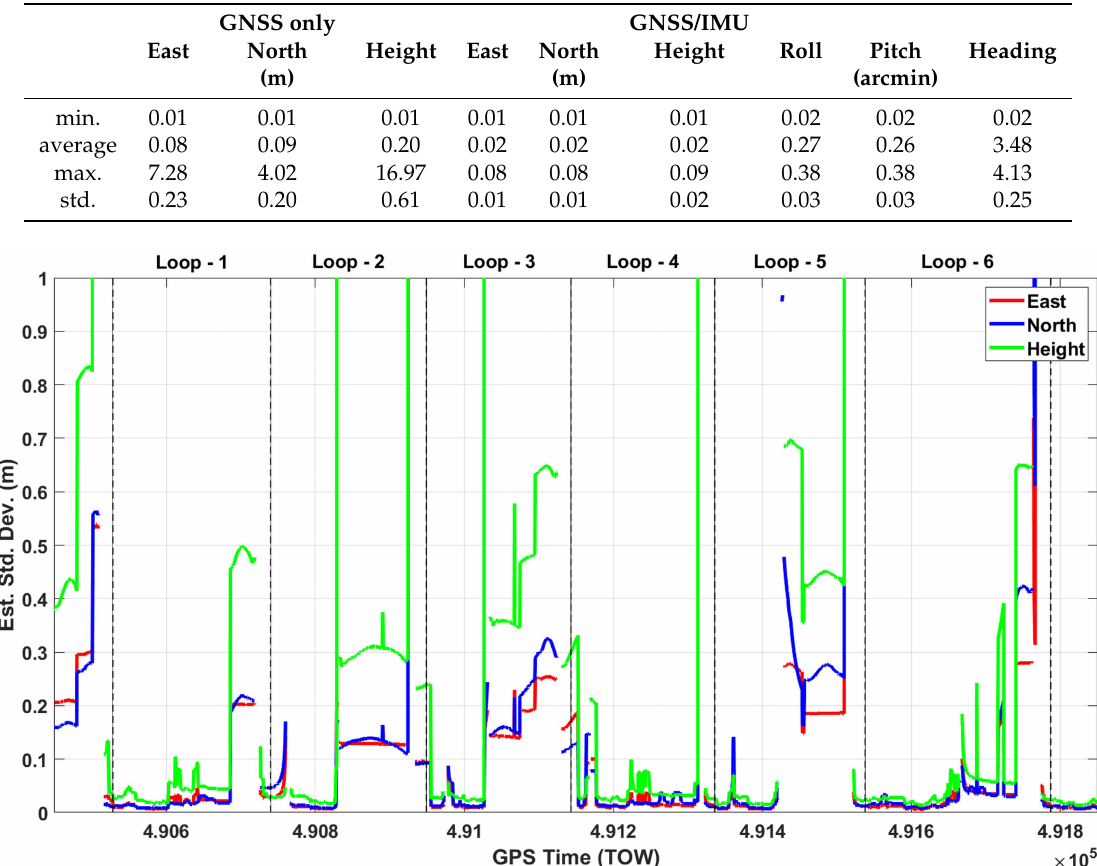
Figure 5. Estimated east, north, and height standard deviations of the GNSS only